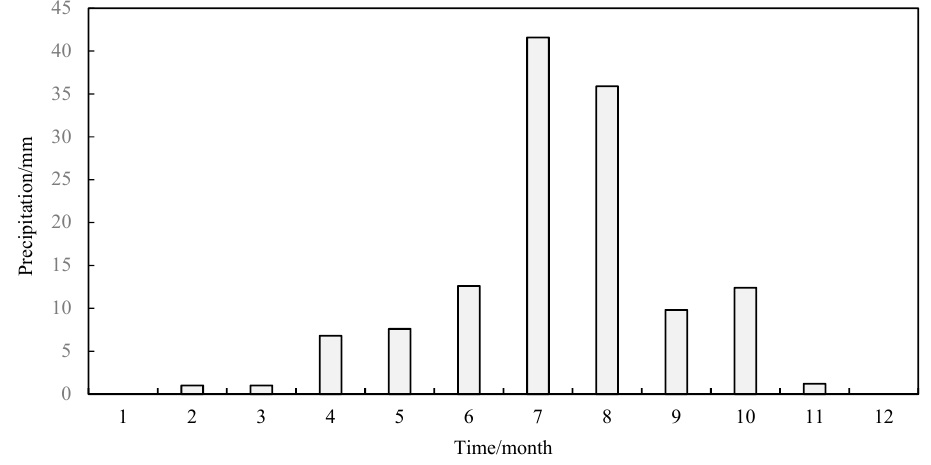
Figure 3. Precipitation distribution for 2014 in Minqin County.